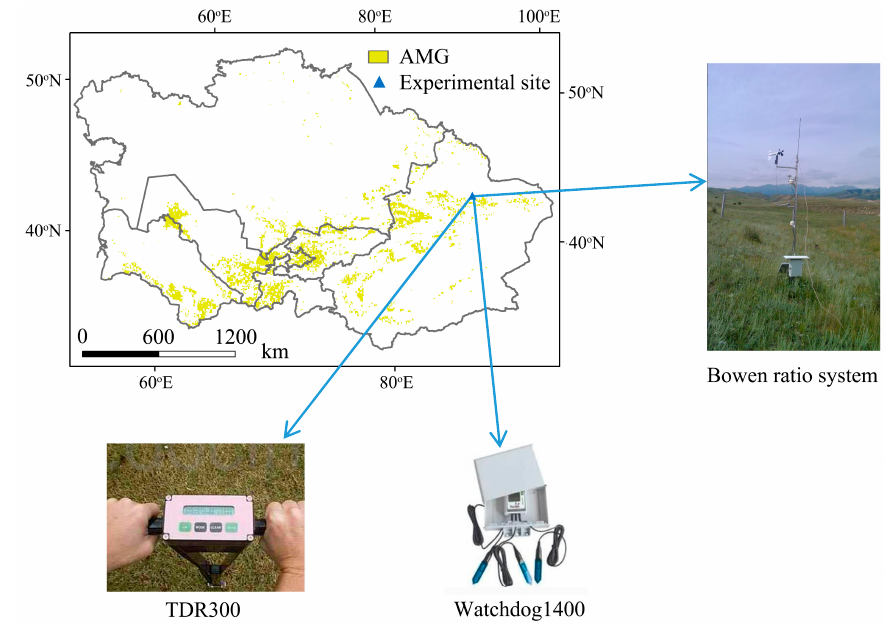
Figure 1. Map of the study area showing the arid mountainous grasslands in Central Asia. (Abbreviation: AMG, arid mountainous grasslands).